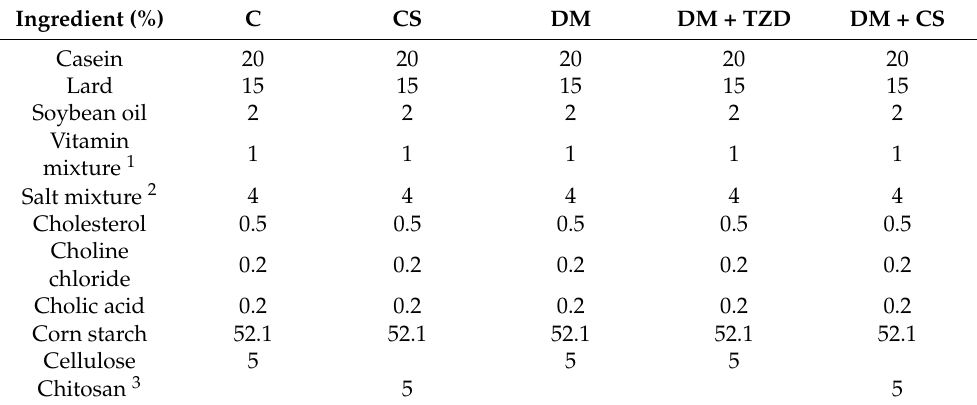
Table 7. Composition of experimental diets